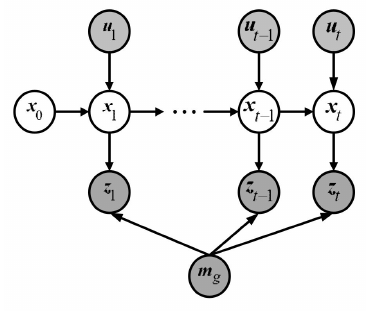
Figure 4. Standard DBN for localization problem.